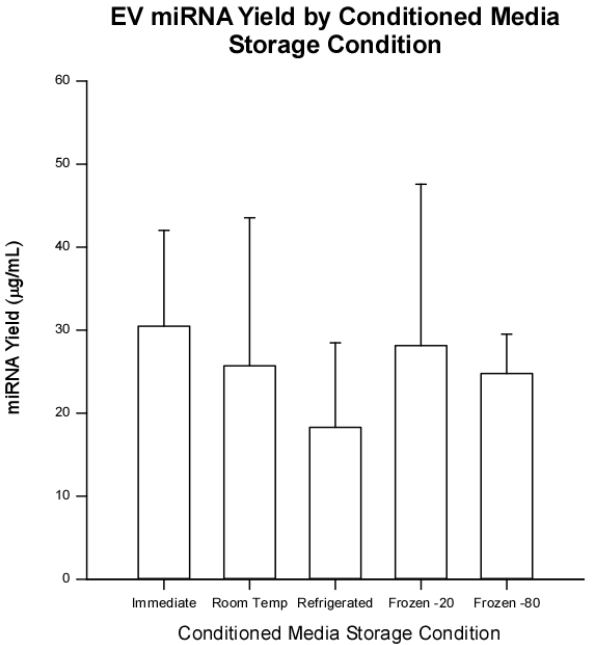
Figure 7. Total microRNA yield (µg/mL) from extracellular vesicles isolated from human umbilical cord-derived mesenchymal stromal cell conditioned media immediately or stored at room temperature, 4 °C, -20 °C, or -80 °C. The trend was for RNA from CM stored at 4 °C to have the smallest yield (18.3 µg/mL). Yields from immediate (30.5 µg/mL), room temperature (25.7 µg/mL), -20 °C (28.1 µg/mL), and -80 °C (24.8 µg/mL) were consistent. No significant differences were noted ( p = 0.07). Data are presented as mean ± standard deviation, n = 5.